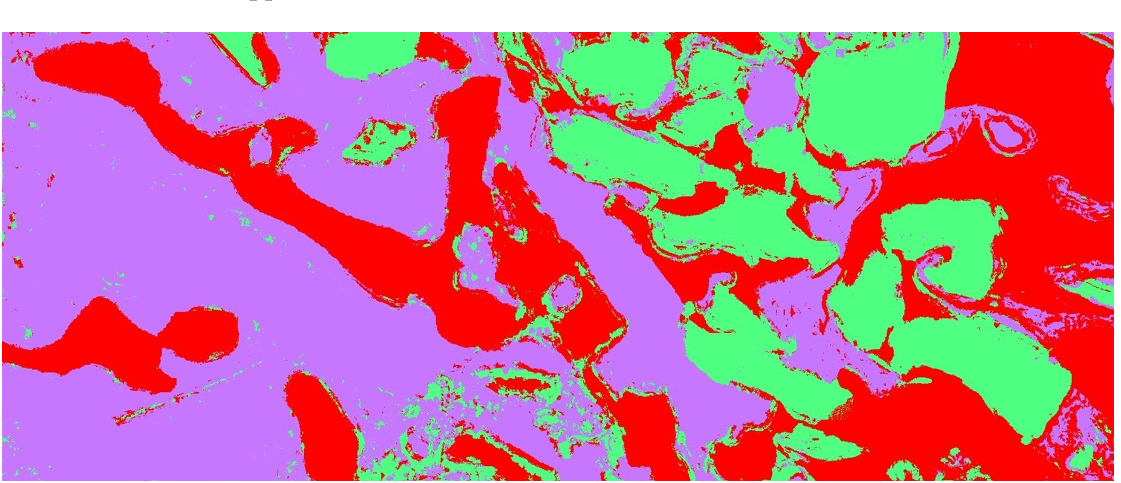
Figure A1. Segmentation of the histological image in Figure 6 with ImageJ software (NIH, http://rsb.info.nih.gov/nih-image, accessed on 20 January 2017), using different colors. Green: residual biomaterial; red: newly formed bone; lilac: soft tissue.